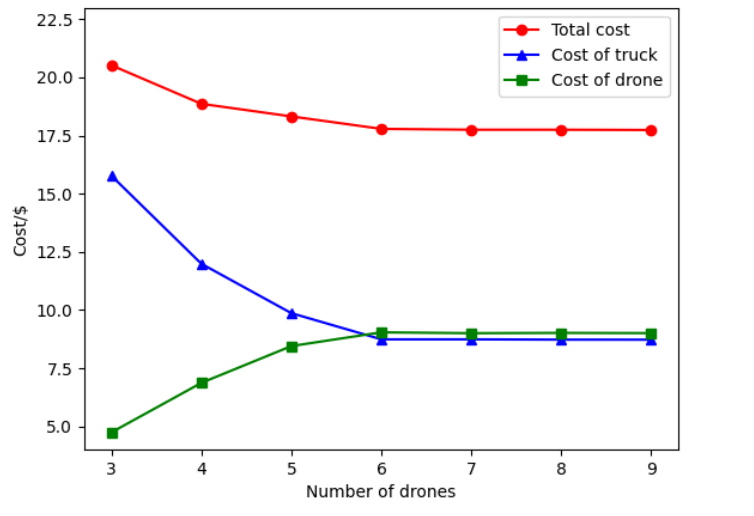
Figure 12. Experimental results under different numbers of drones.